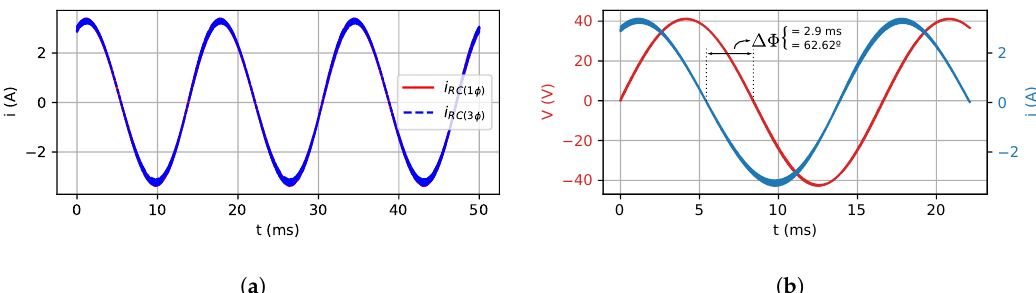
Figure 21. RC load case: ( a ) Load phase currents of single-phase and three-phase (leg 1) models; ( b ) Load phase voltage and current of the single-phase model. Table 4. RMS (root mean square), average, and peak-to-peak values for the simulated currents and voltages: RC load. Quantity RMS Average